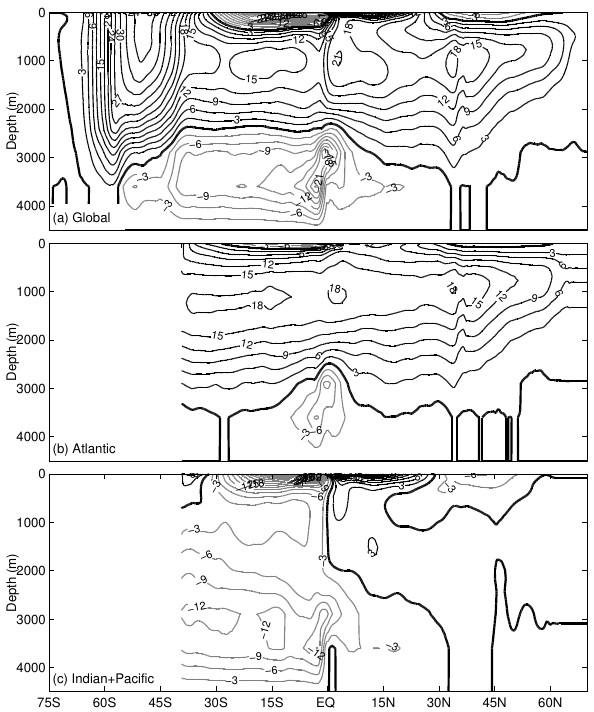
Fig. 5. Time mean, zonally averaged meridional overturning stream Fig.5. Time-mean,zonal-averagedmeridionaloverturningstreamfunction(Sv)forthe(a)entireglobe,(b)At- function (Sv) for the (a) entire globe, (b) Atlantic basin, and (c) lanticbasin,and(c)Indian+Pacificbasins. Solidcontoursarepositive(clock-wise),greycontoursarenegative Indian+Pacific basins. Solid contours are positive (clockwise), grey (anti-clockwise), and bold contours are zero. For clarity, fields have been averaged to eliminate features that contours negative (anticlockwise), and bold contours zero. For clar- areshorterthan1degree. ity, fields have been averaged to eliminate features that are shorter than 1 degree.